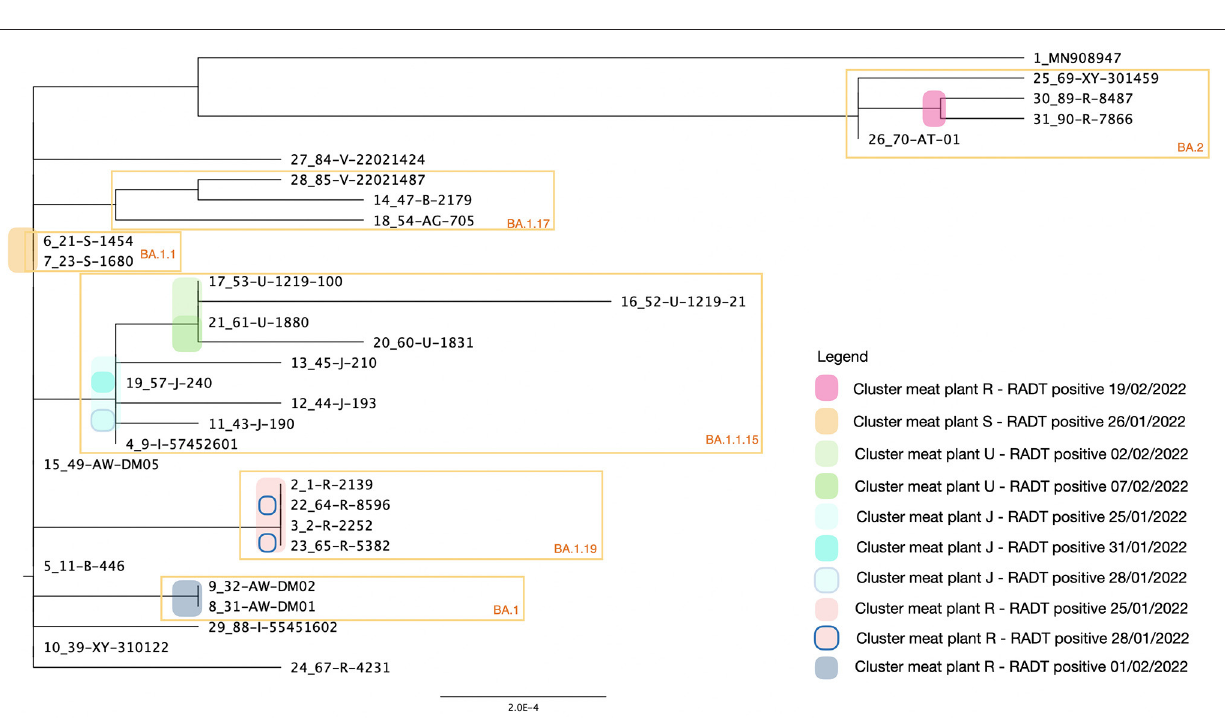
FIGURE 5 | Maximum likelihood phylogenetic tree of the 30 field-samples. The sequences were obtained from the positive RADTs provided by operators in the MPPs and treated with the developed protocol described in this study. The six yellow squares highlight the clusters and the colored spots on the branches of the tree, group the related samples with the same date of isolation. The clusters are annotated based on the average distance among the sequences and the tree is rooted with the reference MN908947 (Severe acute respiratory syndrome coronavirus 2 isolate